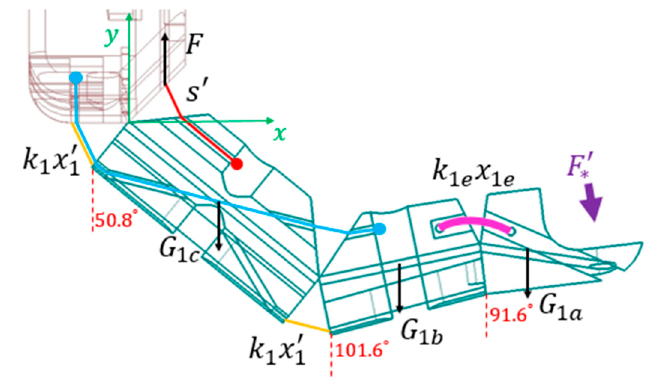
Figure 14. Complete hyperextension of index finger.